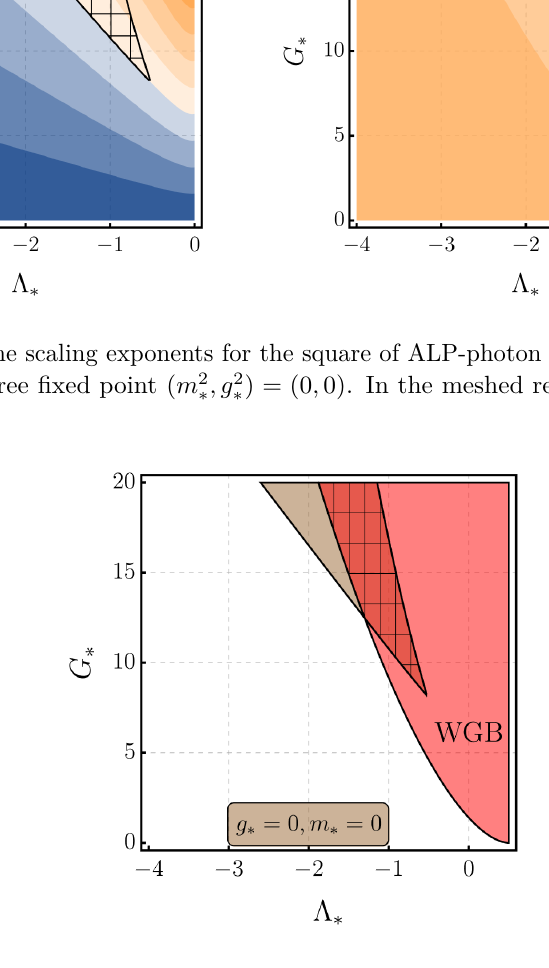
Figure 3 . In red, we show the region which is forbidden by the WGB and in brown the region where the free fixed point at g = 0 , m = 0 has two relevant directions. Only the brown region ∗ ∗ without the meshing style is allowed by the